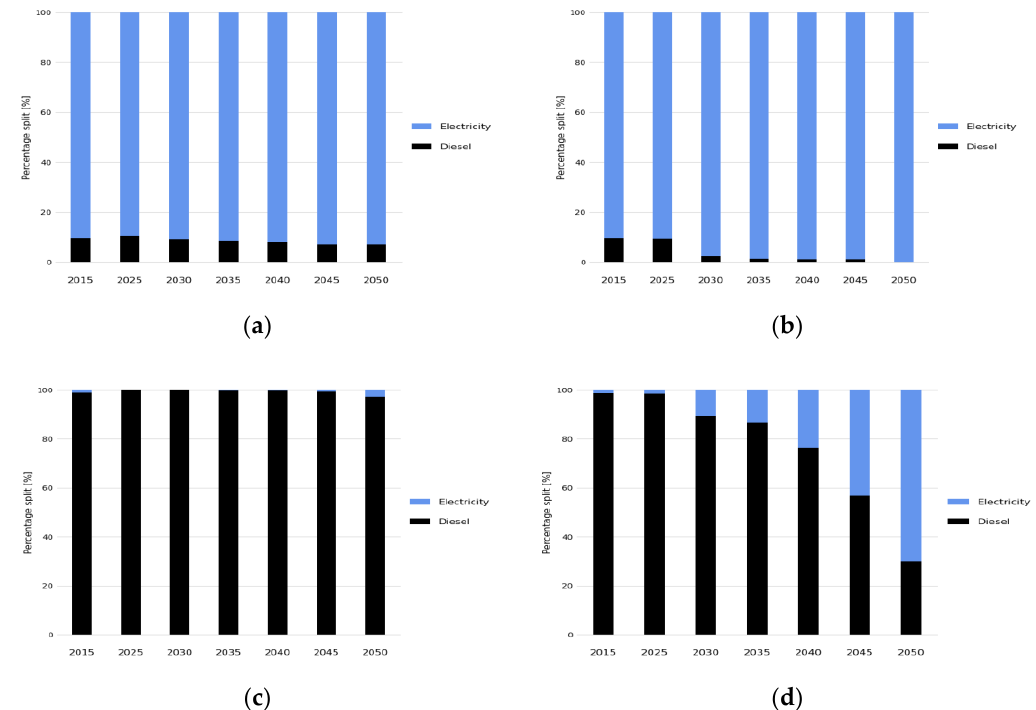
Figure 9. Electrification of passenger rail (up) and freight rail (down) over time for different scenarios (represented in terms of share in total passenger–km/ton–kilometer travelled): ( a ) passenger rail, LME scenario; ( b ) passenger rail, P1.5 °C scenario; ( c ) freight rail, LME scenario; ( d ) freight rail, P1.5 °C scenario.